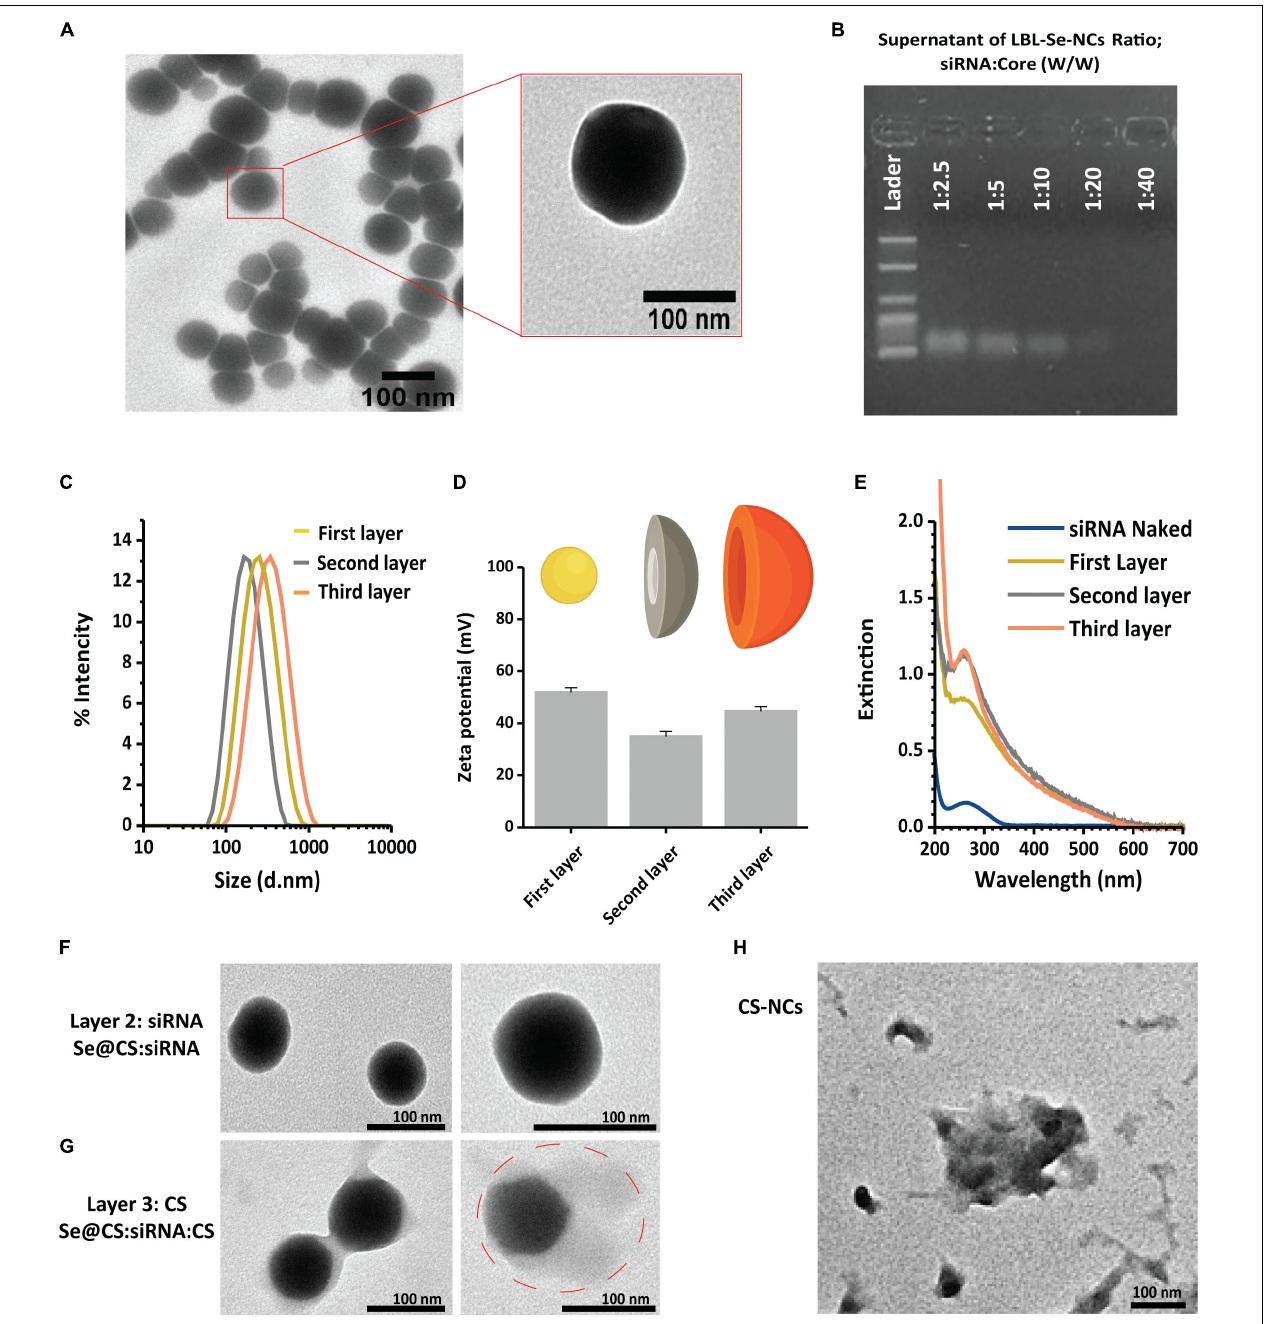
FIGURE 1 | Synthesis of LBL-Se-NCs. (A) TEM images of Se@CS nanoparticles. The images confirmed the formation of SeNPs and indicate an average particle size of around 74.3 ± 5 nm. (B) The siRNA-loading capacity of Se@CS nanoparticles, from 1:2.5 to 1:40 siRNA:core mass ratios, was evaluated by measuring the remaining siRNA content in the supernatant by agarose gel electrophoresis. (C,D) The hydrodynamic diameter (C) and the surface charge (D) of the nanoparticles were evaluated with dynamic light scattering after each step in the synthesis process. The first layer corresponds to Se@CS, the second layer to Se@CS:siRNA, and the third layer to Se@CS:siRNA:CS. ( n = 3). (E) UV-Visible spectra of the different stages of the LBL synthesis of Se-NCs. (F) TEM images of Se@CS:siRNA (G) and Se@CS:siRNA:CS. (H) TEM images of